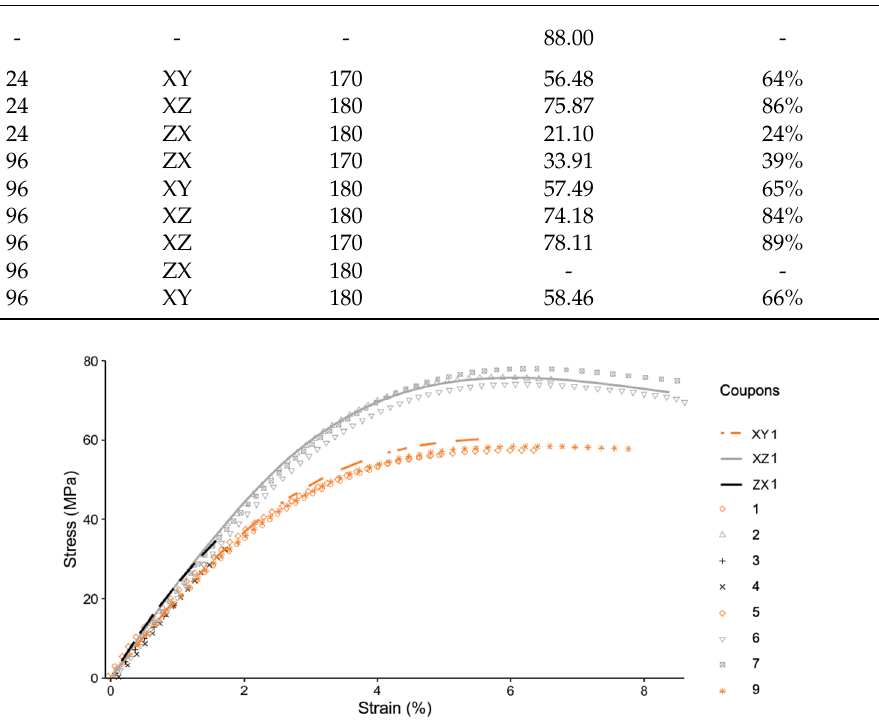
Figure 7. Stress–Strain curve for all coupons (excluding the injection molded).